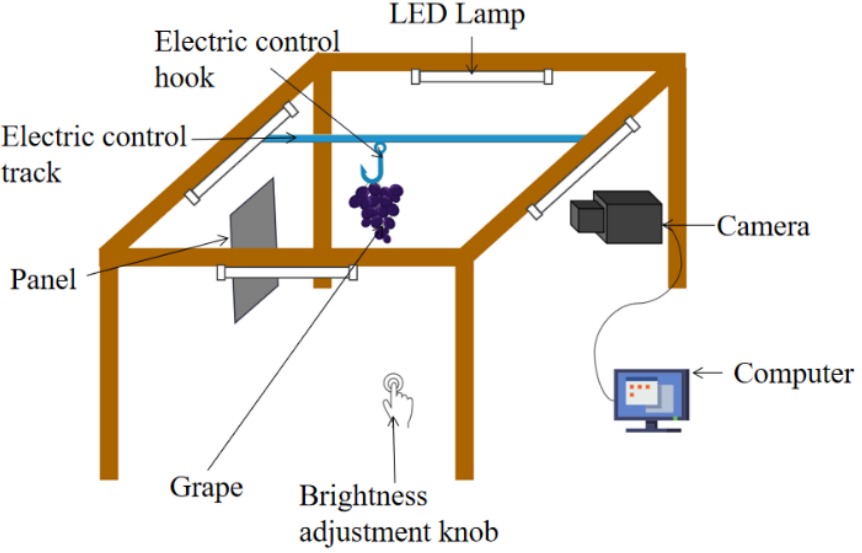
Figure 1. Grape image acquisition system.